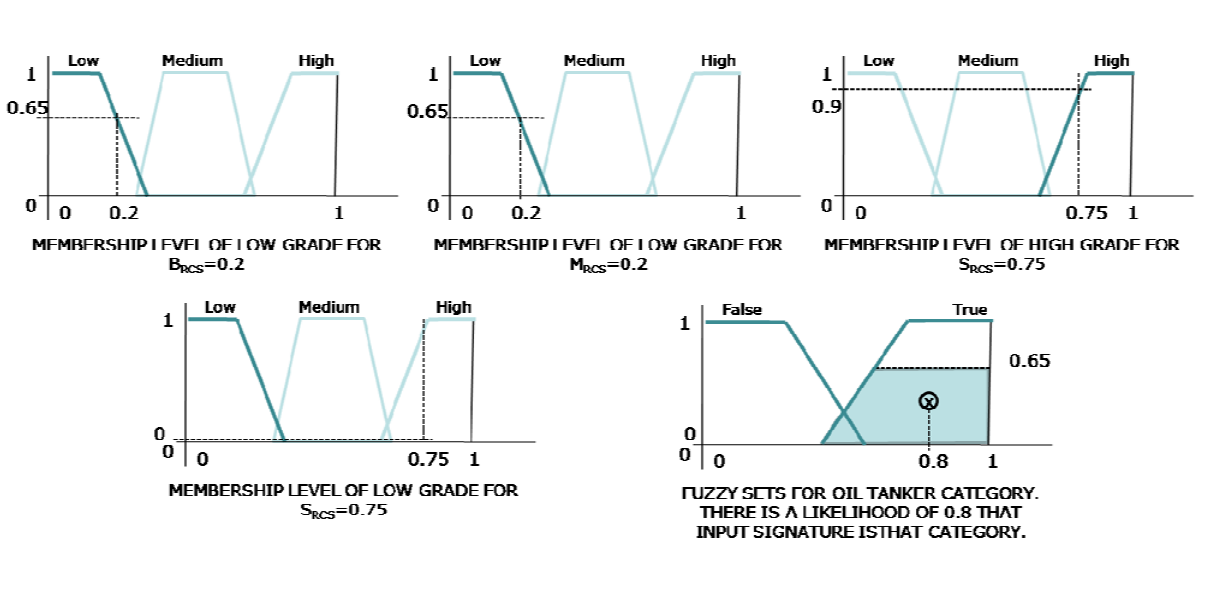
Figure 6. Illustrative description of fuzzy logic processing. The plots refer to a hypothetic input signature that is cross-checked against the Oil Tanker